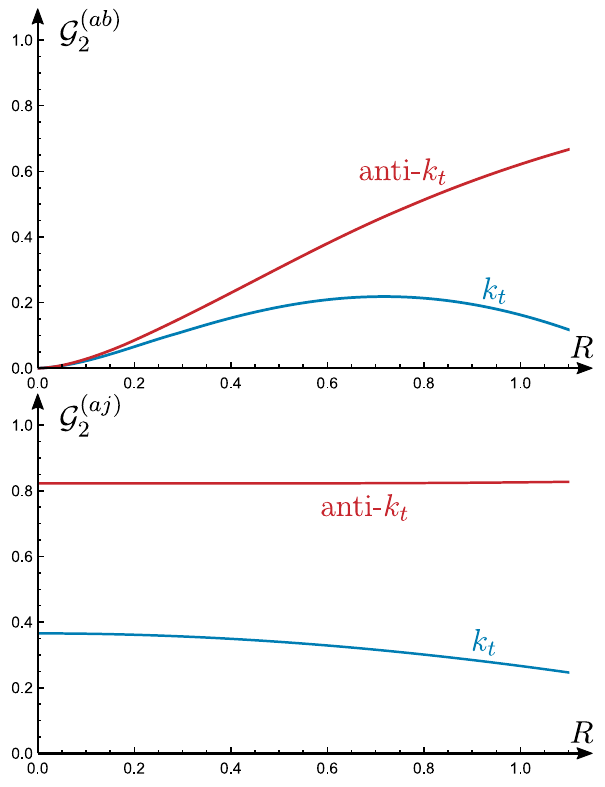
Fig. 7 NGLs coefficients at two loops with anti- k t and k t clustering